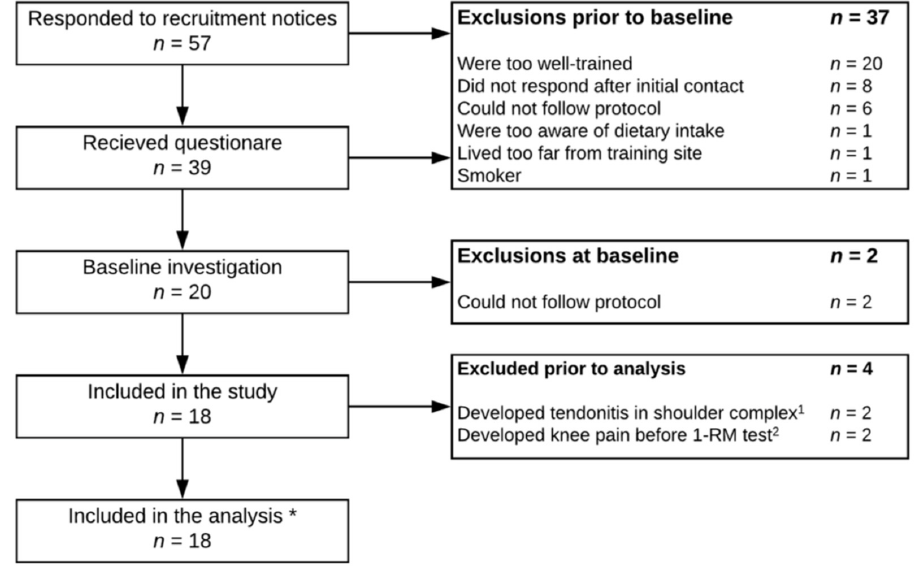
Figure 1. * Only 14 subjects were included in all analyses; 1 Lower-body data were still included in analysis; 2 Data from maximal voluntary contraction (MVC) test and counter-movement jump (CMJ) were still included in analysis.